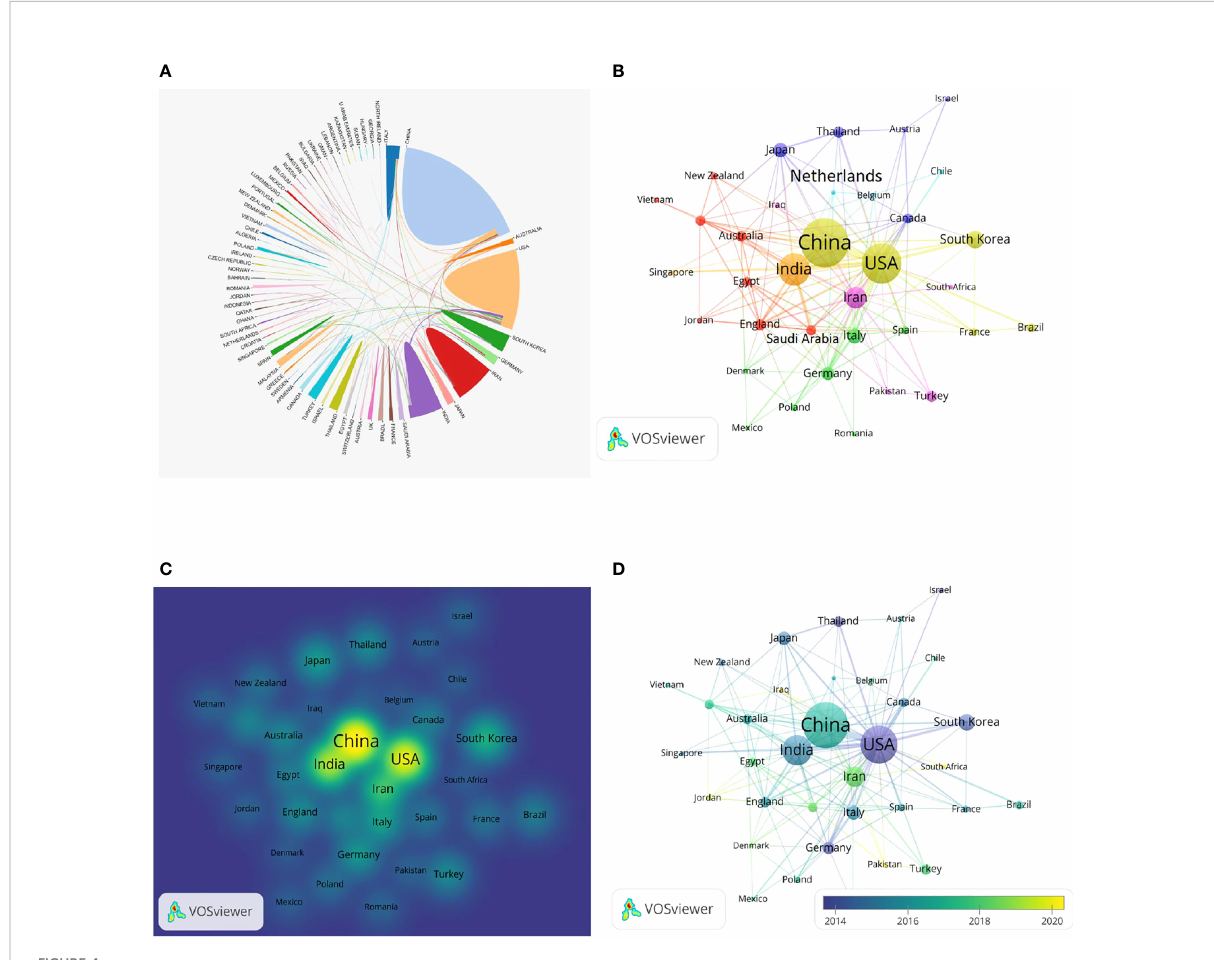
FIGURE 4 Overview of national publications. (A) Cooperation among different countries. (B – D) The collaboration network of